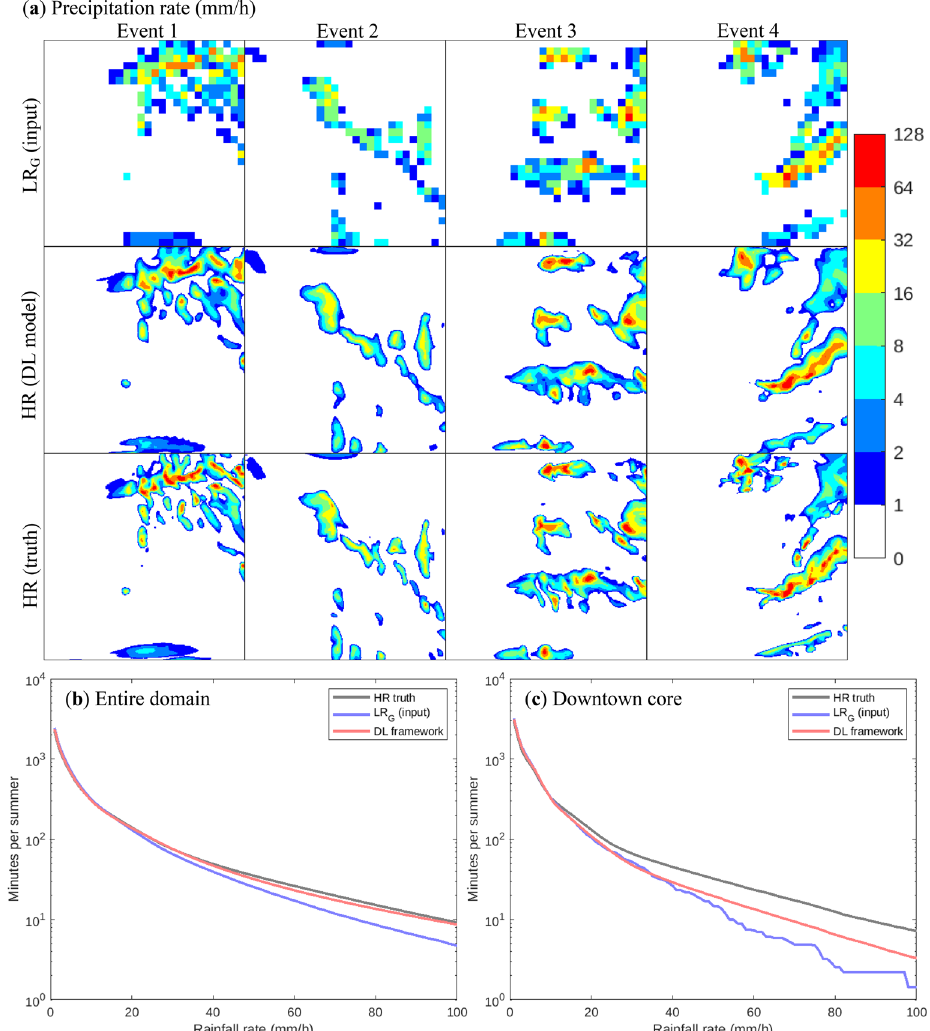
Fig. 2 a Precipitation fields (mm/h) for select high-intensity precipitation events, from LR G (top), DL model (middle) and HR truth (bottom). b Frequency–intensity relationships for the three datasets in a , over the entire HR domain. c As b , but for Montreal’s downtown